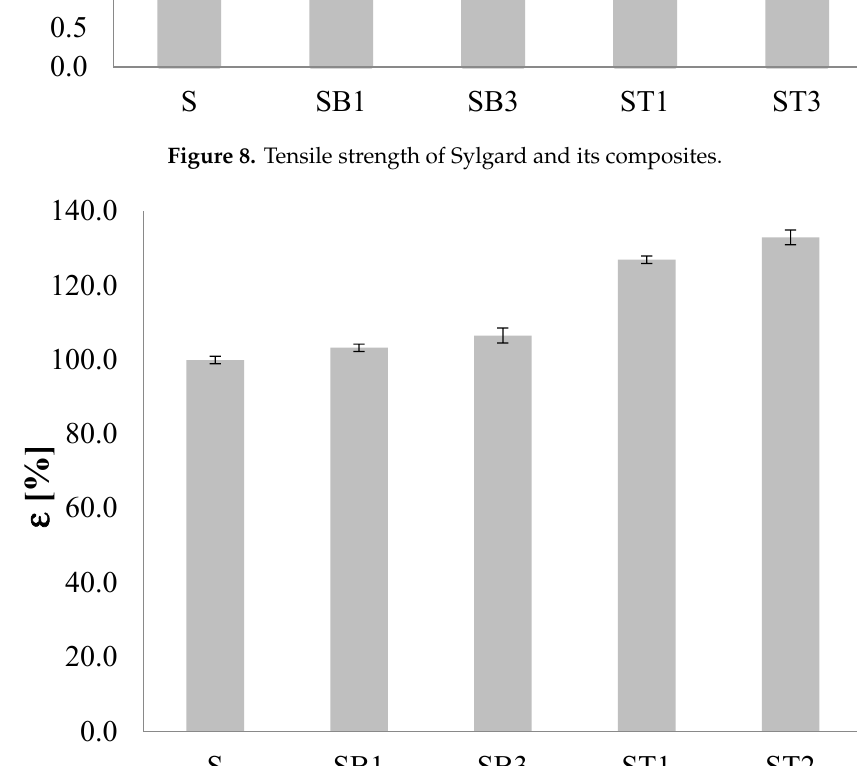
Figure 9. Elongation at break of Sylgard and its composites.